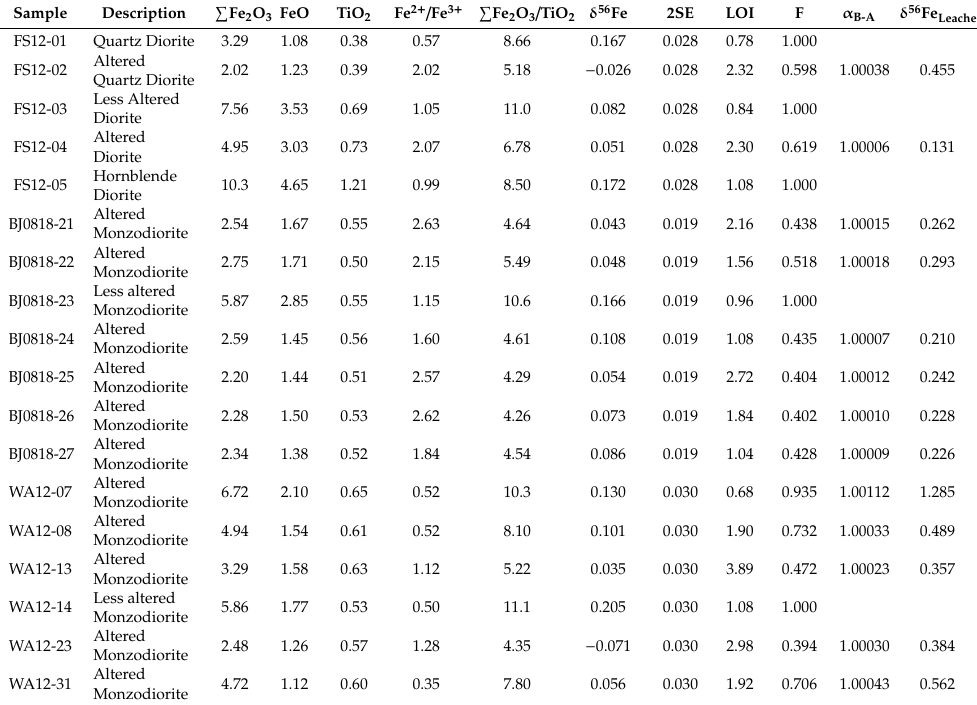
Table 4. Selected major elements and Fe isotope composition of altered plutonic rocks from the Han-Xing iron skarn deposit.